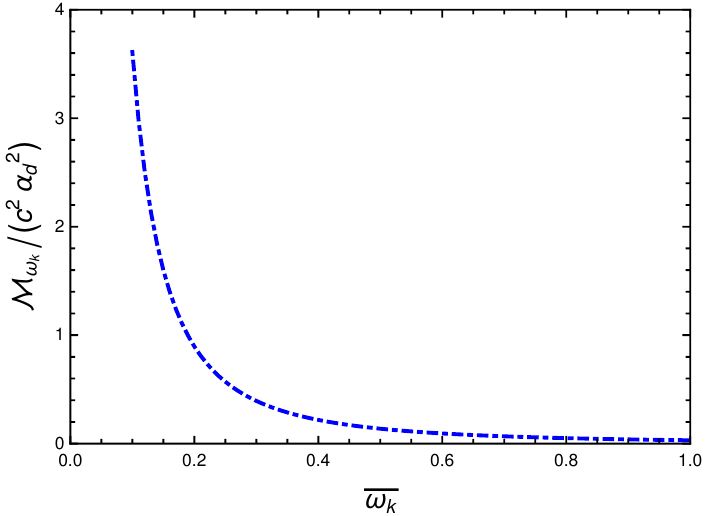
( ρ ) / ( c 2 r 2 ) perceived by two out going null detectors AB H k = α for fixed transition frequency k d ω k = 1 . Here we have also considered α = ω 2 . d d k x k /